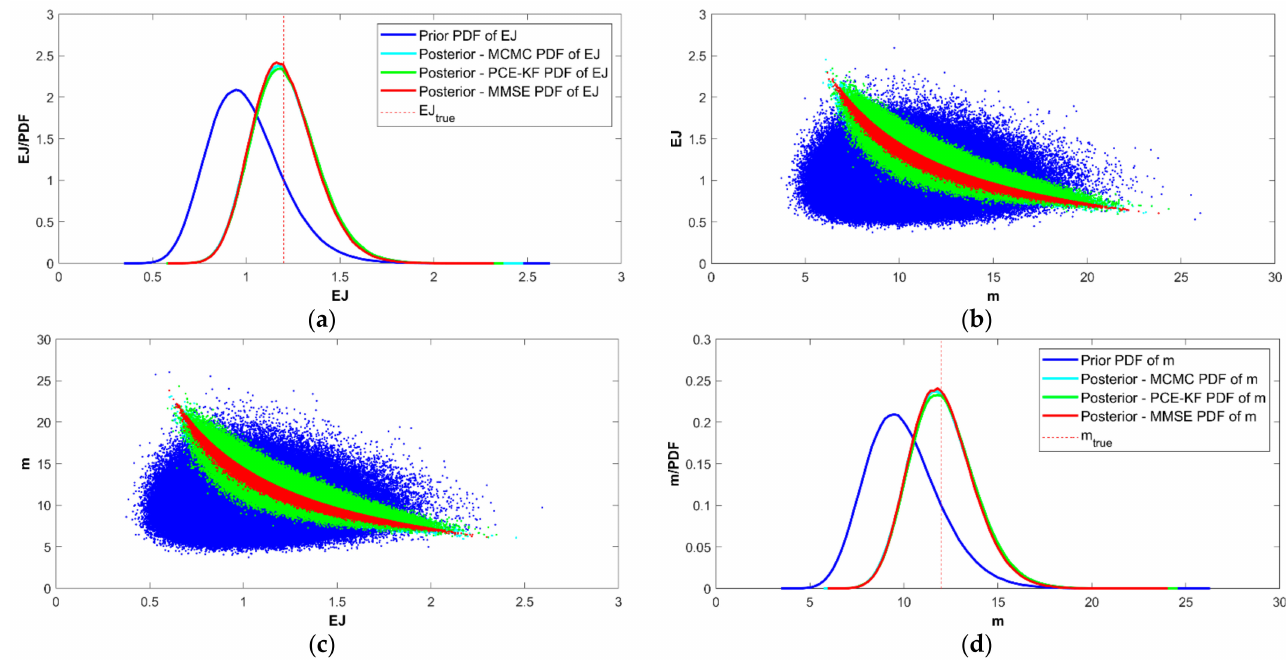
Figure 11. Comparison of different updating methods with two uncertain parameters—SDOF: ( a ) prior and marginal posterior pdfs of EJ , ( b ) scatterplot of the samples of the prior and posterior pdfs , ( c ) prior and marginal posterior pdfs of m and ( d ) scatterplot of the samples of the prior and posterior pdfs. The prior distributions and the results of the different methods are shown with different colors: prior (in blue), MCMC (in cyan), PCE-KF (in green) and MMSE (in